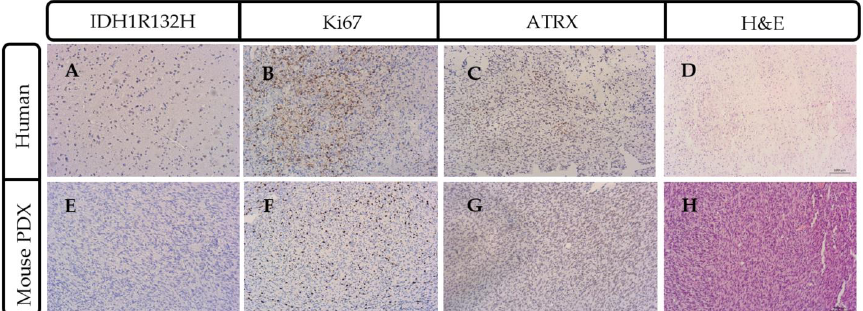
Figure 3. Parental patient tumor mutational status was recapitulated in PDX mouse